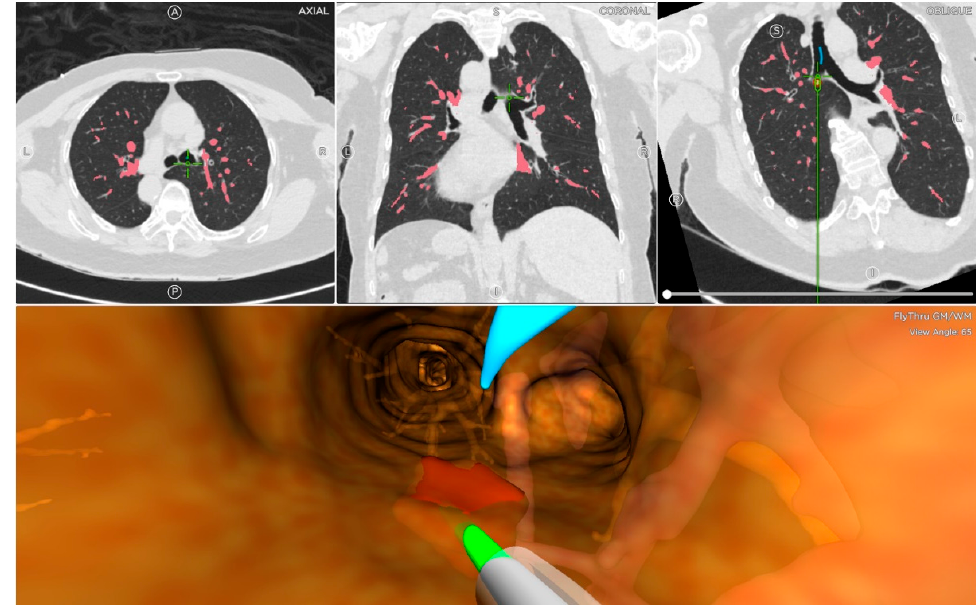
Figure 2. Veran electromagnetic navigational bronchoscopy leading to the lesion.